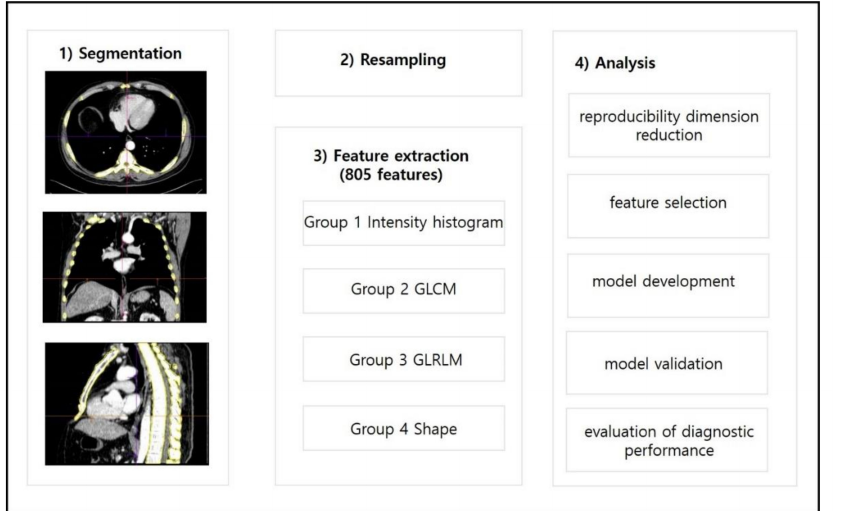
Figure 3. A methodological flow chart of this study (GLCM, Gray Level Co-occurrence Matrix; GLRLM, Gray Level Run Length